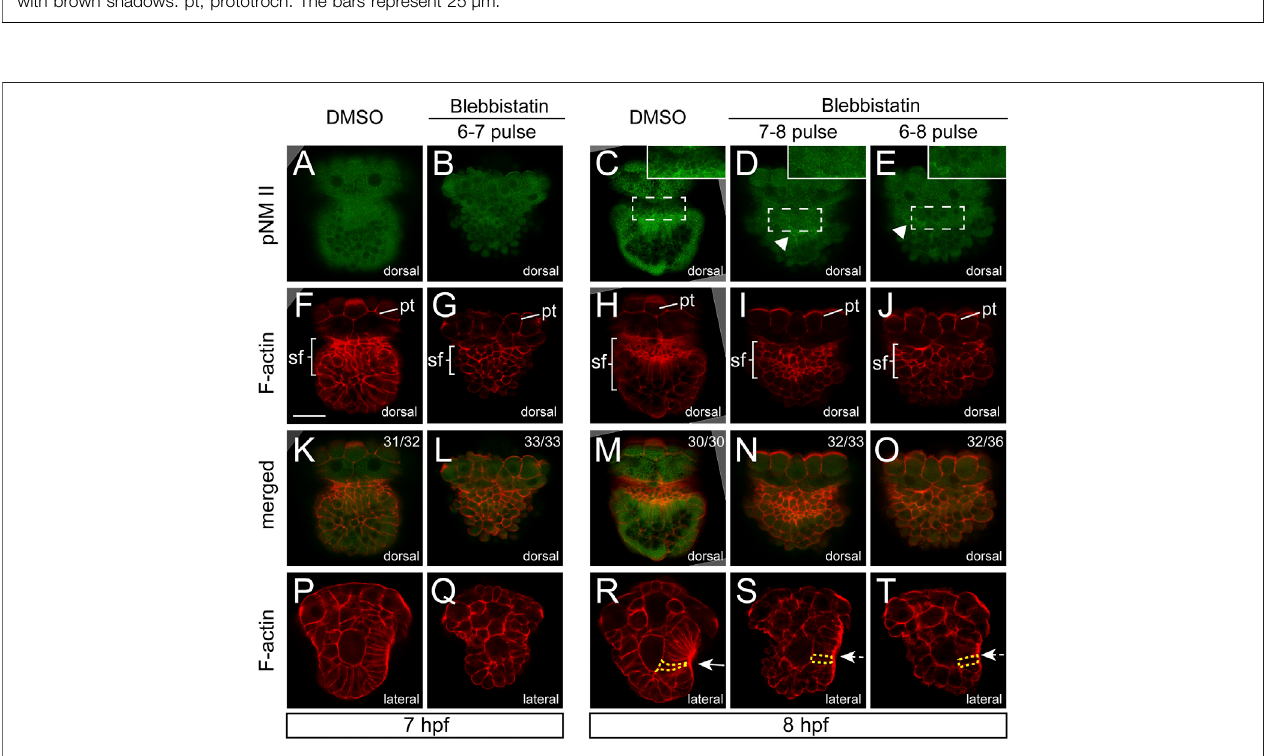
FIGURE 5 | Aggregations of F-actin and pNM II were inhibited by blebbistatin treatments. Panels (A – O) show dorsal views, anterior to the top. Generally, aggregations of F-actin and pNM II were inhibited by blebbistatin treatments. The arrowheads in (D,E) indicate residual pNM II signals. A linear intensity pro fi le for each labeled region in panels (C – E) is provided in Supplementary Figure S1 . Panels (P – T) show lateral views anterior to the top and dorsal to the right. The invagination of theshell fi eldisevidentincontrolembryos[thearrowin (R) ]butisinhibitedinmanipulatedembryos[dashedarrowsin (S,T) ].Onerepresentativecellofeachgroupis outlined by yellow dashed lines to show the differences in the cell shape (R – T) pt, prototroch. The bar represents 25 μ m.